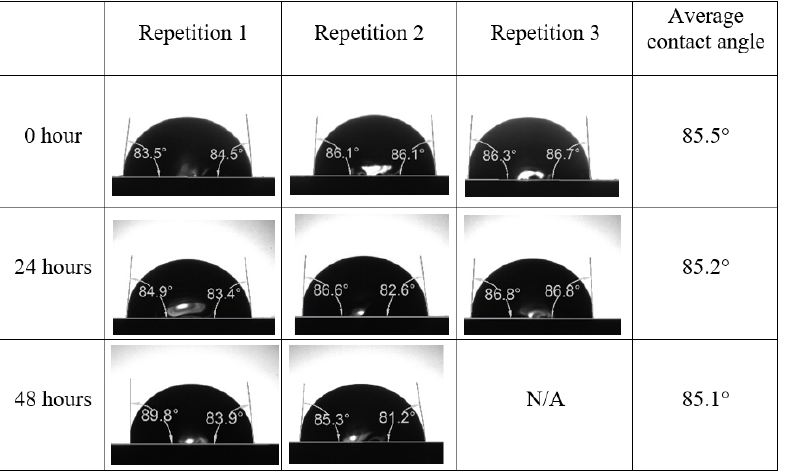
Figure A16. Dynamic Contact Angle Measurement Results for 50% MgCl 2 + 50% Na 2 SO 4 (3500 ppm).